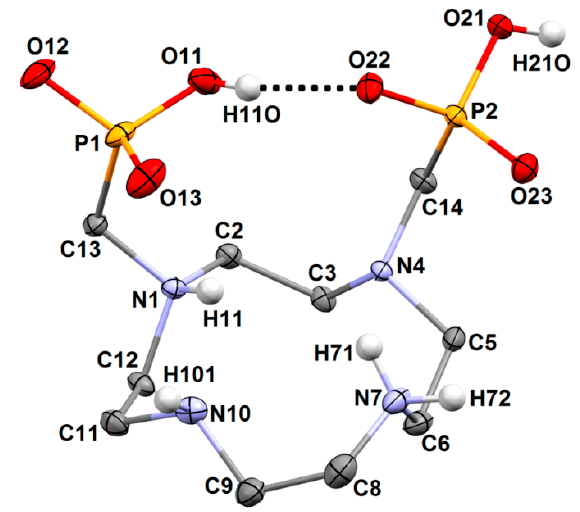
Figure 2. Molecular structure of 1,4-H 4 do2p found in the crystal structure of 1,4-H 4 do2p · 4H 2 O. Carbon-bound hydrogen atoms are omitted for clarity. The intramolecular hydrogen bond is shown by the dotted line.